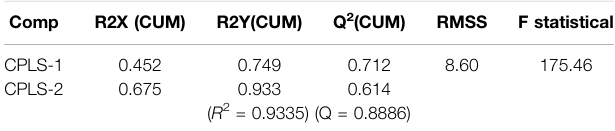
TABLE2| StatisticalparametersofthePLSmodelresultingfromOSCinteractions with the IAM phase.